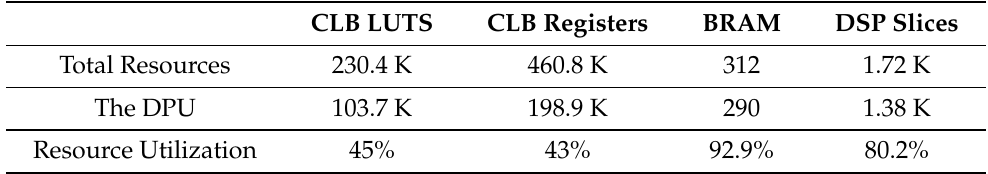
Table 5. DPU Resources Utilization on ZCU